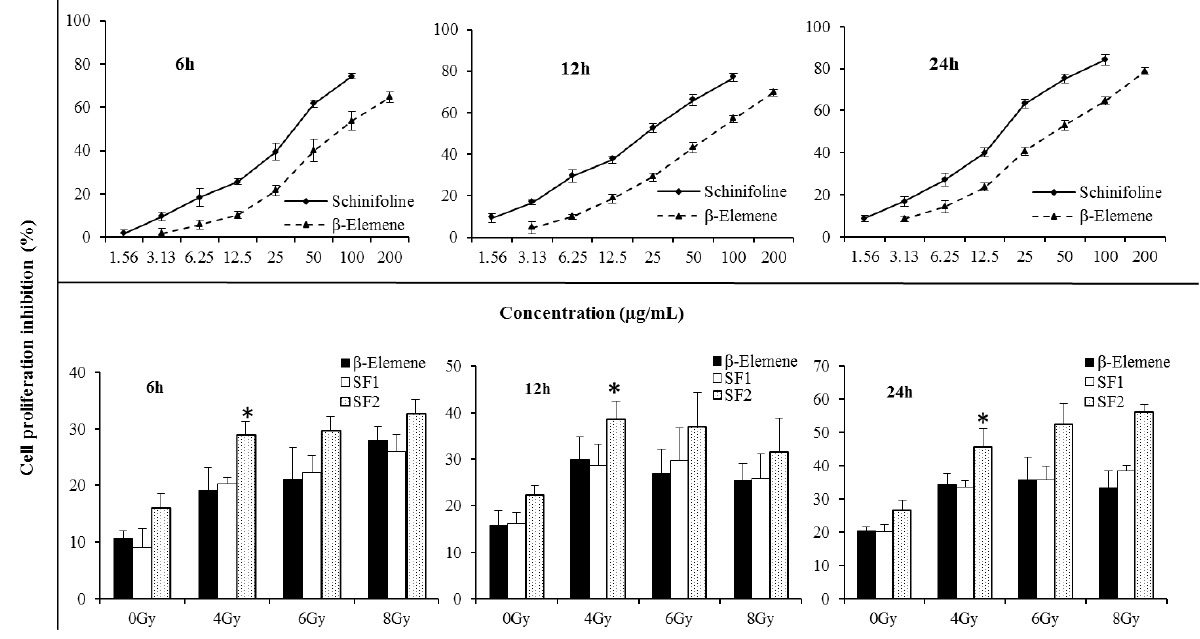
Figure 2. Cell proliferative inhibition A549 by CCK-8 assay. The three curve charts represented cell proliferative inhibition effect of β -elemene/schinifoline ranging from 0 to 200 µg/mL in A549 after 6, 12 and 24 h treatment, respectively. The three bar charts showed cell proliferative inhibition A549 which were treated with β -elemene (15 µg/mL) or schinifoline (SF 1 , 2 µg/mL; SF 2 , 4 µg/mL) alone or in combination with irradiation. The cells were incubated with drugs for 12 h, thereafter, growth media were replaced with fresh medium and the cells were irradiated with single IR doses of 4, 6 and 8 Gy, the cell inhibition was recorded after 6, 12 and 24 h, respectively. Each value is the mean ± SD of six determinations. * p < 0.01, compared with SF 1